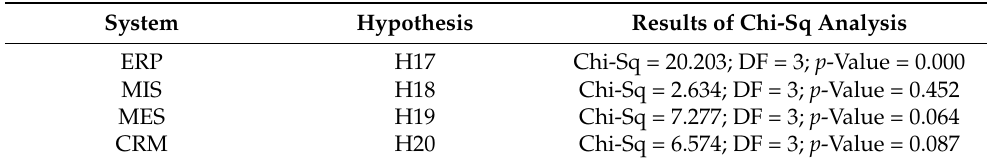
Table 6. Results of Chi-Sq analysis for ERP, MIS, MES, and CRM systems depending on number of machines (More than 50, From 5 to 50, Less than 5, No machines).